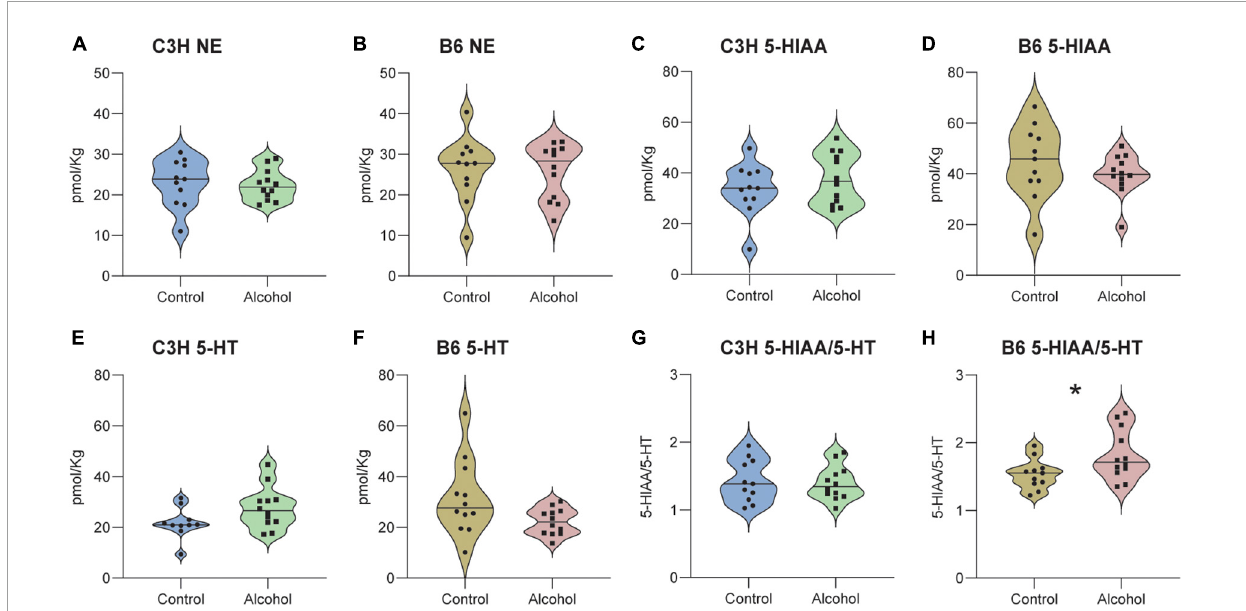
FIGURE10 Neurotransmitter levels following alcohol exposure in the hippocampus of C3H and B6 mice. The levels of norepinephrine (NE) (A,B) , 5-HIAA (C,D) , 5-HT (E,F) , and 5-HIAA/5-HT (G,H) in the hippocampus of C3H and B6 mice. Data are shown as individual subjects with violin plots. n = 11–12 per group/strain. * p < 0.05 represents mixed model repeated measures (MMRM) followed by Benjamini–Hochberg’s post hoc , alcohol vs. control.